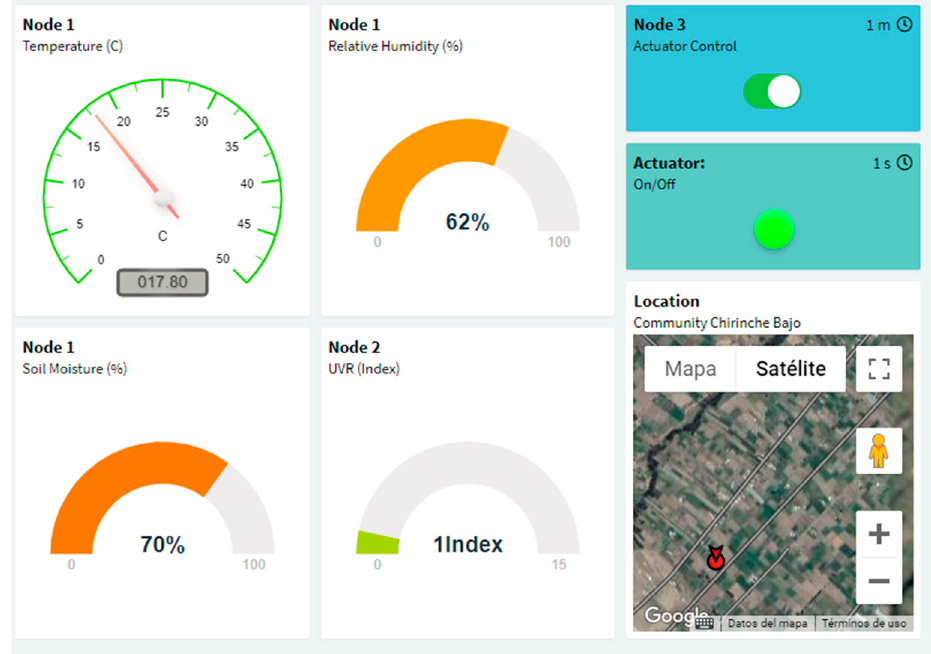
Figure 6. User Interface.